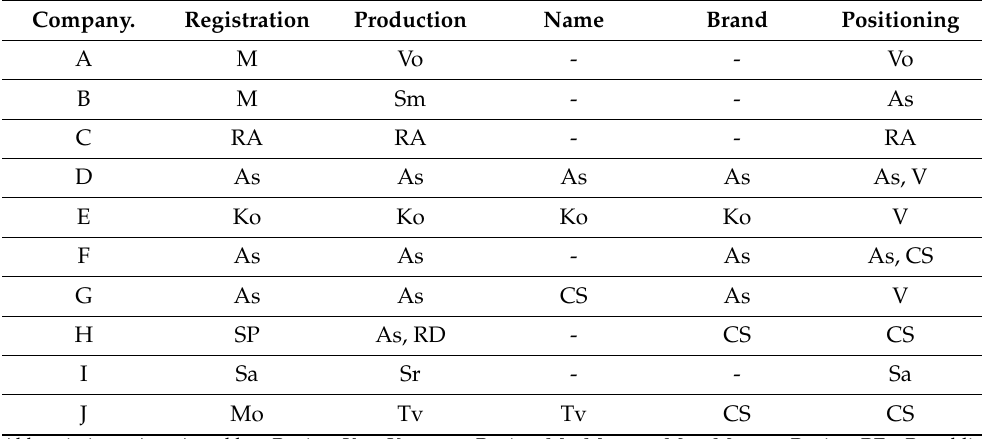
Table 2. Sub-national geographical affinities of the Russian full-cycle black caviar producers consid- ered in this study.